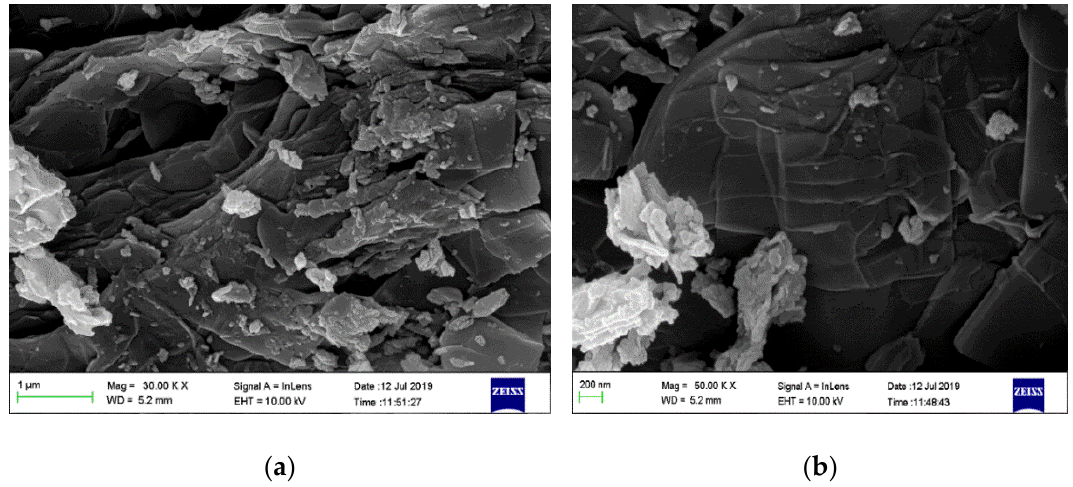
Figure 2. Surface morphology of hydroxy sodalite: ( a ) low magnification (5000 × magnification (5.00 kx) and ( b ) high magnification (50,000×).